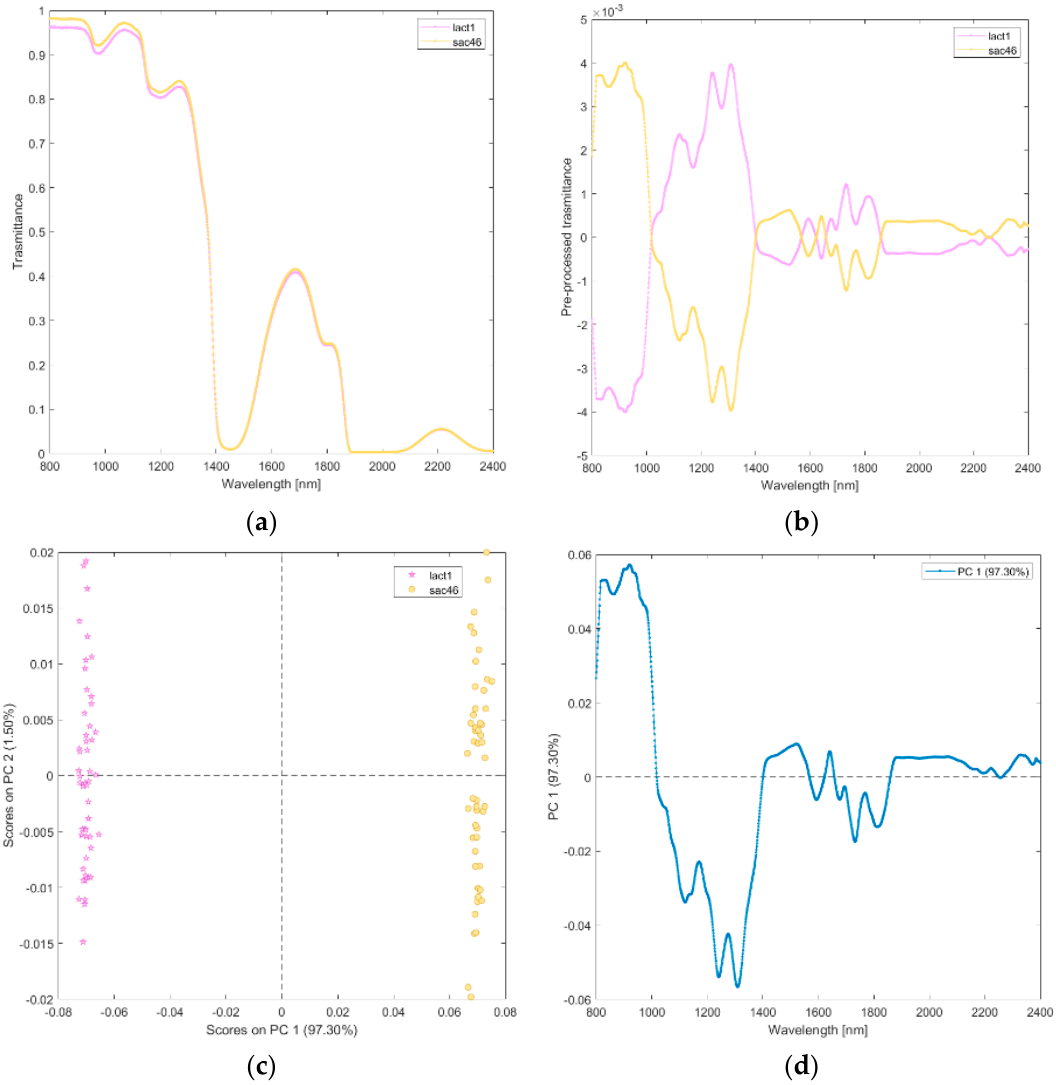
Figure 10. Average raw ( a ) and pre-processed ( b ) transmittance spectra for sucrose (sacc46), and lactose (lact1). PC1 − PC2 score plot ( c ) and loading plot of PC1 ( d ) for sucrose (sacc46), and lactose (lact1).